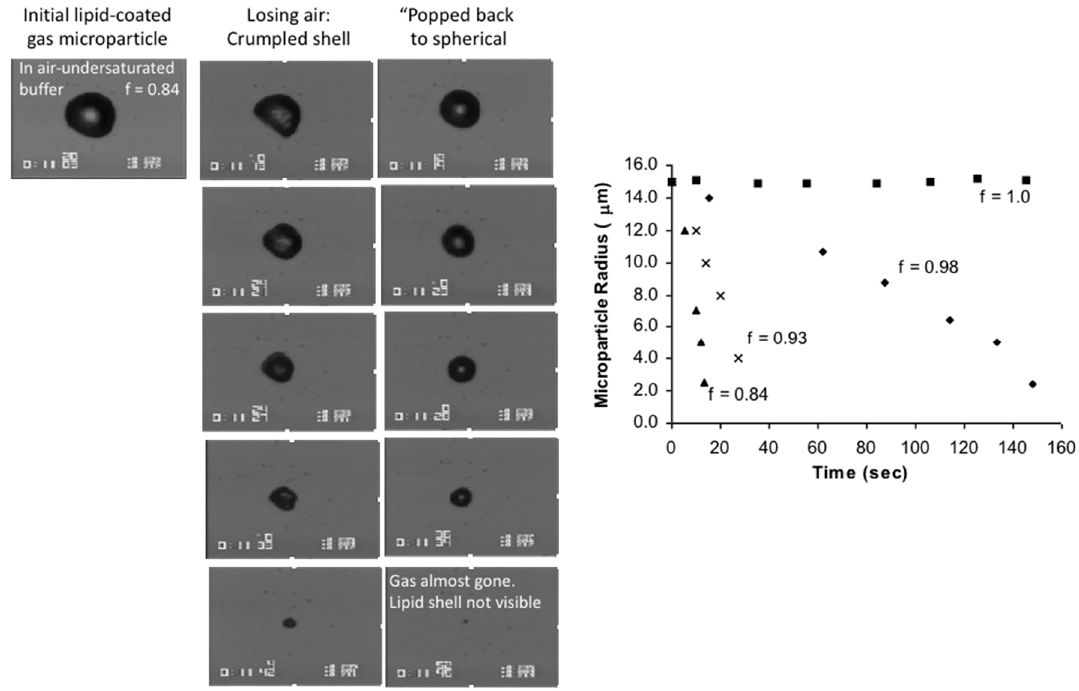
Figure 22. Lipid ‐ coated gas microparticle losing air in undersaturated solution. The degree of air ‐ water saturation, f, is the ratio of the initial air concentration in surrounding water to the saturated concentration of air in water. ( Left ) Videomicrograph of the initial lipid-coated gas microparticle in f = 0.84. ( Middle ) Series of lipid-coated gas-microparticles losing air, the shell crumples, and then pops back to spherical as lipid is shed until there is no gas left; ( Right ) plot of microparticle radius vs. time for gas microparticles losing air at increasing air saturation. The microparticle in the saturated solution (f = 1) is stable.